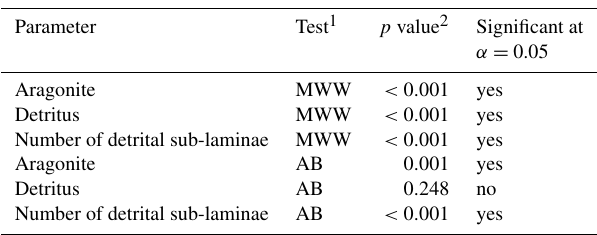
Table 2. The p values of the statistical comparison between the bulk studied